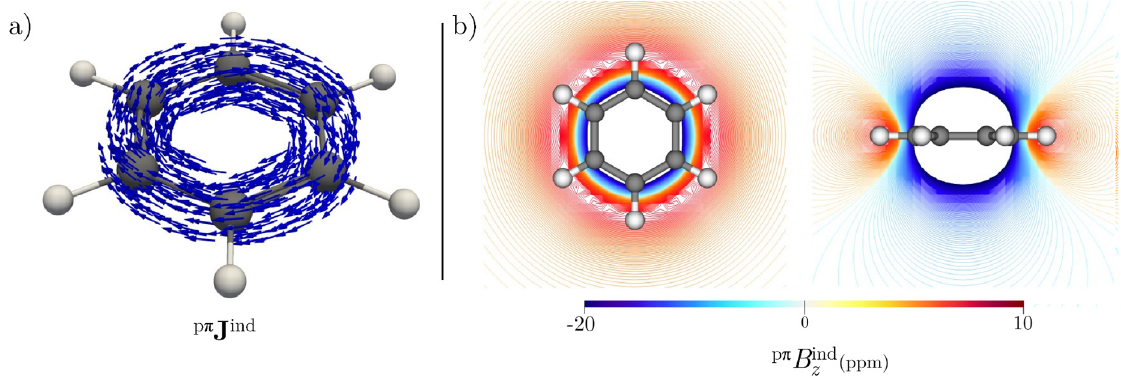
Figure 2. ( a ) p π J ind vector maps showing the diatropic ring current (in blue) of benzene. ( b ) Isolines of p π B ind z calculated in the transverse plane (left) and the molecular plane (right) of benzene. The white areas surrounded by negative (or positive) values correspond to regions where the shielding (or deshielding) magnitude is larger than the values chosen for the color